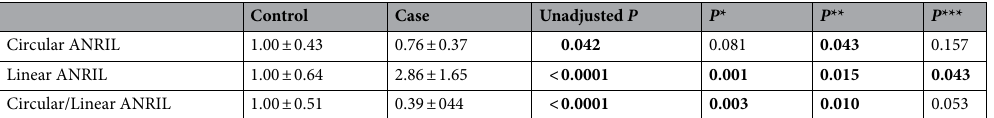
Table 4. Univariate and multivariate analyses of ANRIL expression between control and case group. Bold values imply statistical significance. *Adjusted for age, sex, and BMI. **Adjusted for age, sex, BMI, diabetes, dyslipidemia, and hypertension. ***Adjusted for age, sex, BMI, diabetes, dyslipidemia, hypertension, smoking Habit, and history of atherosclerosis.